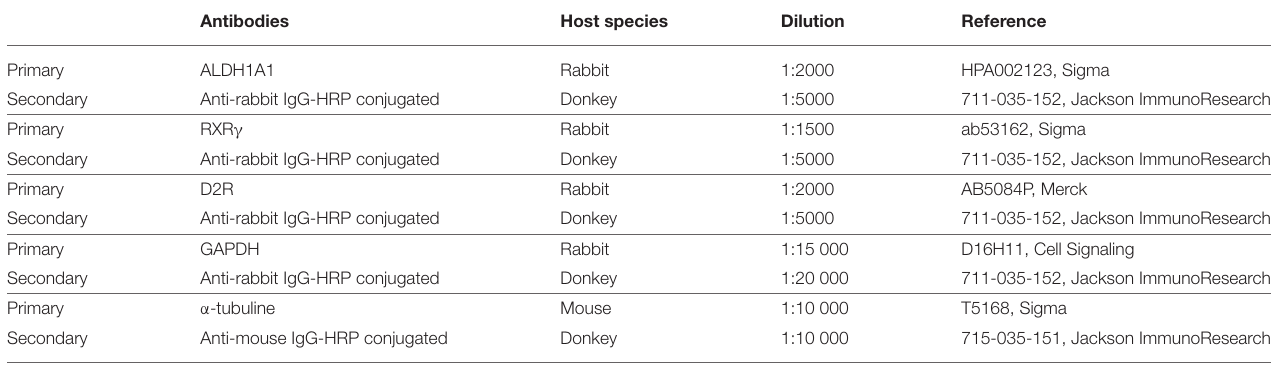
TABLE 1 | Reagents and resources used for western blot experimentation. Antibodies Host species